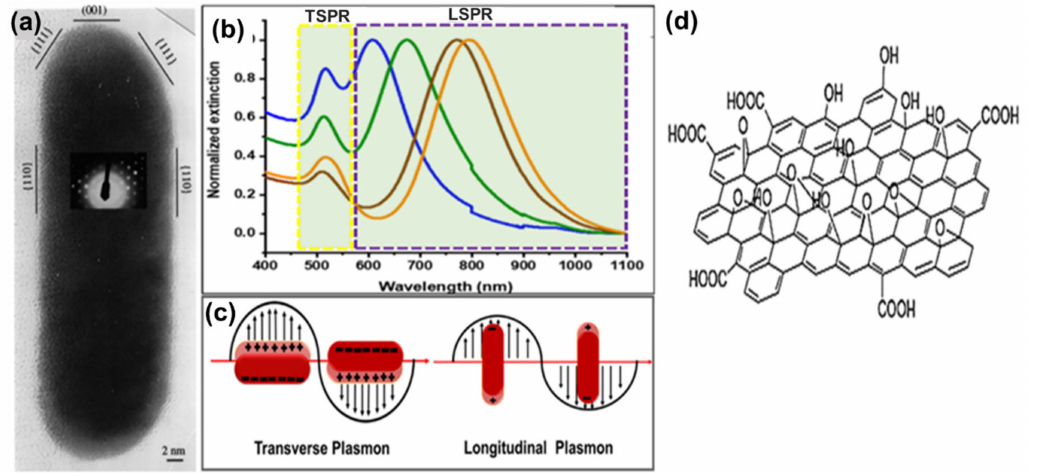
Figure 1. ( a ) High-resolution TEM image of gold nanorods (AuNRs) oriented along the (110) direction, showing the faceted crystal structure of the rod; the inset is the electron di ff raction pattern recorded from the rod, which proves the single crystalline structure of the rod. Adapted from ref [18], with permission from Elsevier, 1999. ( b ) UV − Vis − NIR spectra of AuNRs with di ff erent transverse surface plasmon resonance (TSPR) and TSPR wavelength position. Adapted from ref [19], with permission from American Chemical Society, 2018. ( c ) Diagram illustrating the conduction band electron oscillation upon transverse ( left ) and longitudinal ( right ) localized surface plasmon resonances of AuNRs. ( d ) Typical structure of graphene oxide Adapted from [20] with permission from RSC advances,